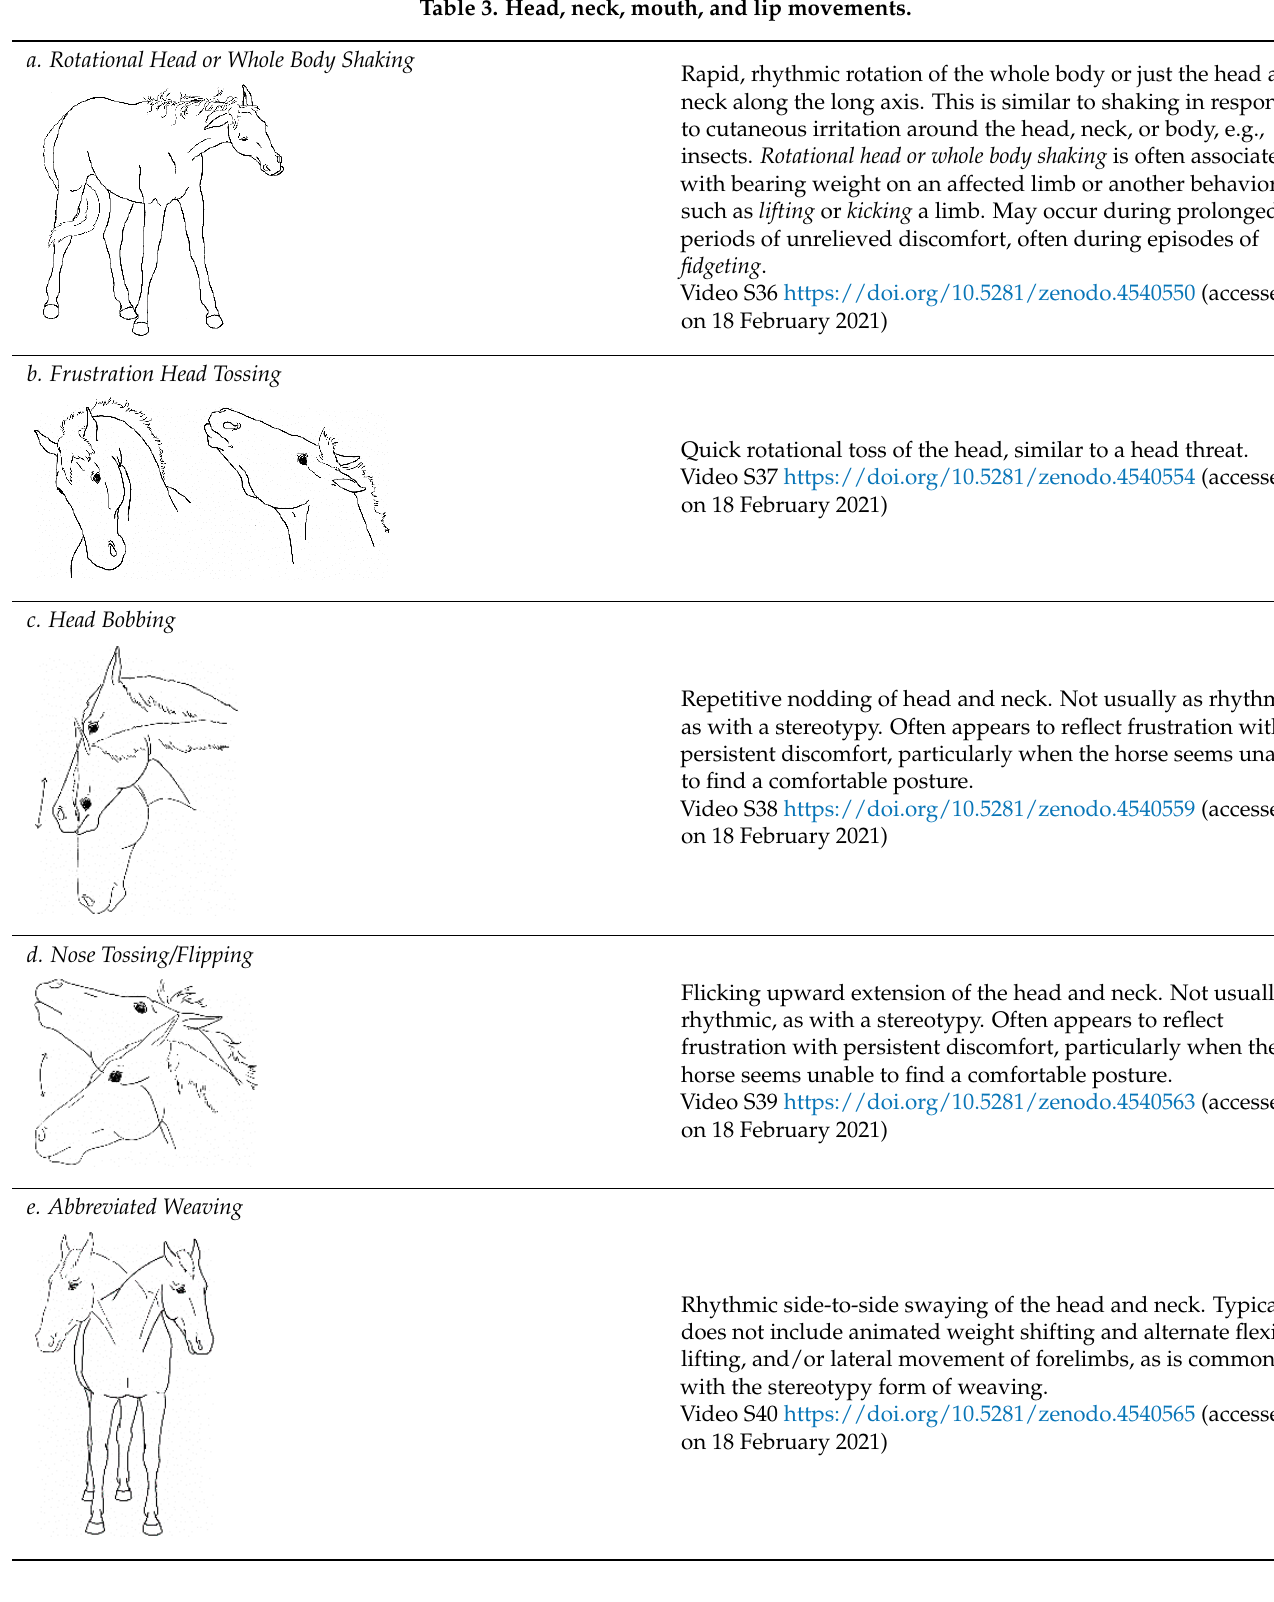
Table 3. Head, neck, mouth, and lip movements.